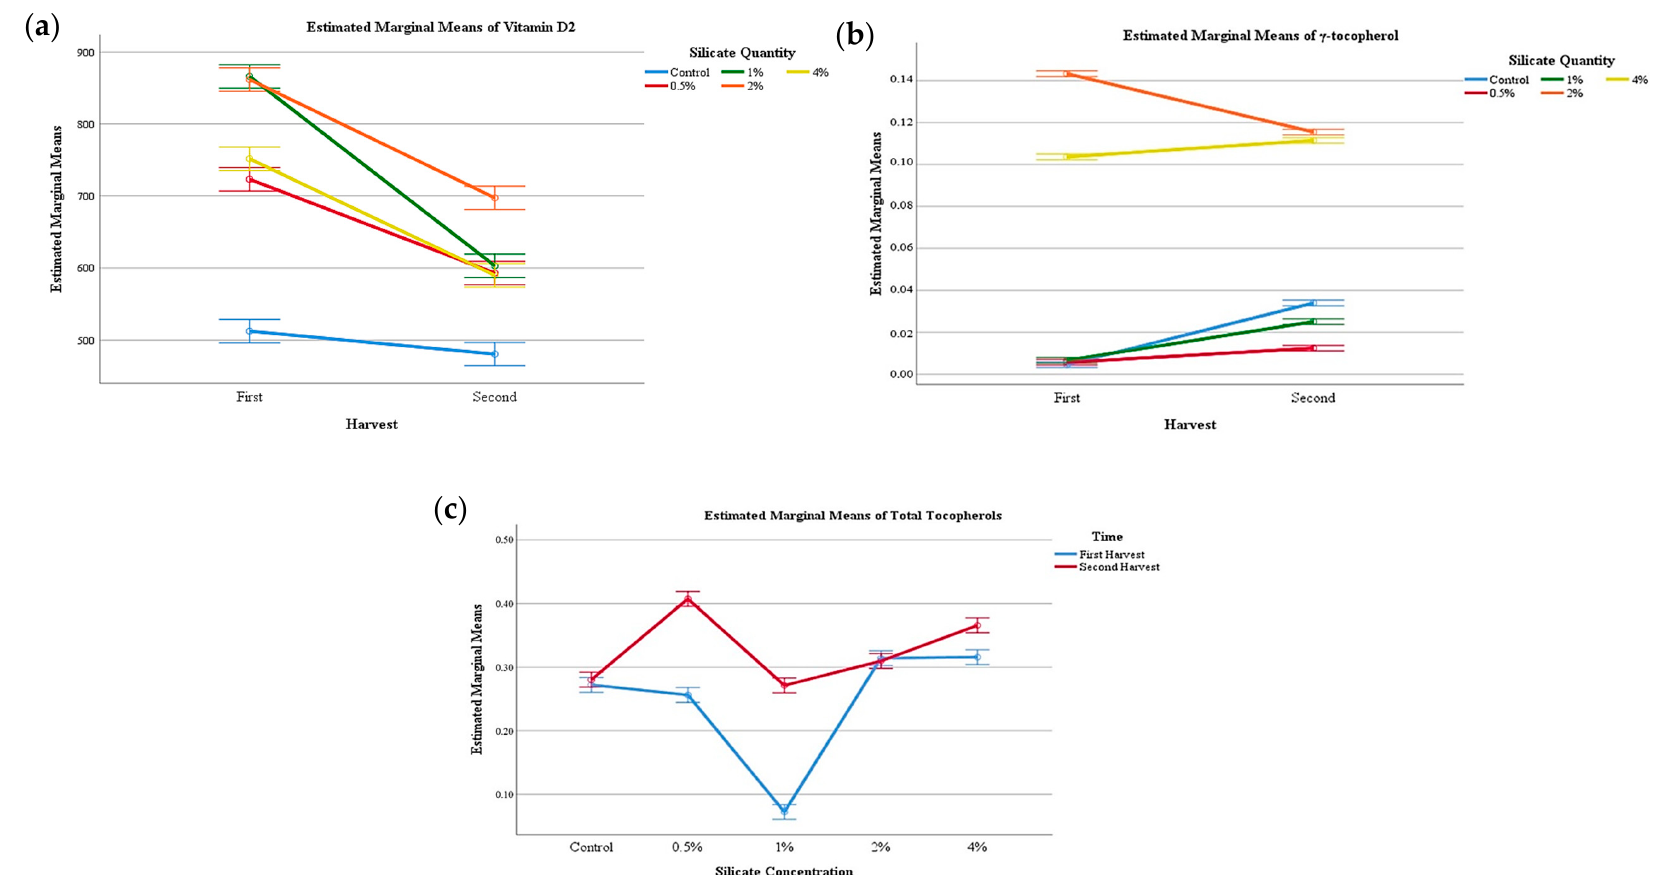
Figure 1. EMM plots of the Presidente Prudente mushrooms during the two harvest periods: ( a ) vitamin D 2 , ( b ) γ -tocopherol. EMM plots of Mogi-das-Cruzes at different Si concentrations: ( c ) total tocopherols.